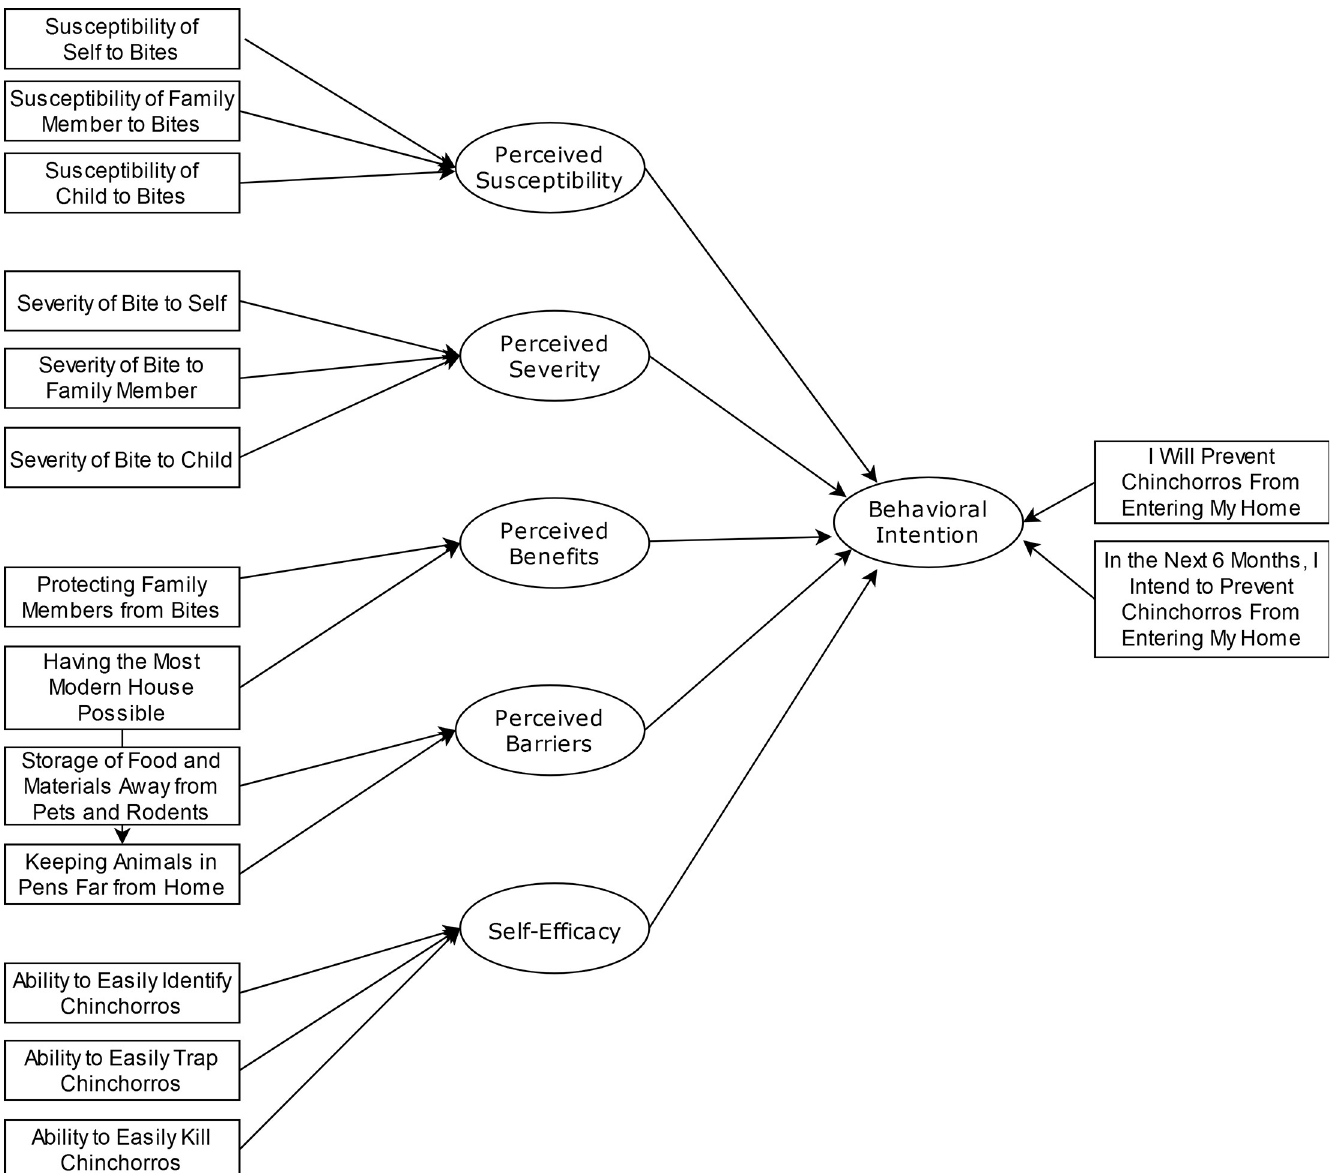
Fig 2. Relationships among HBM concepts and HBM questionnaire